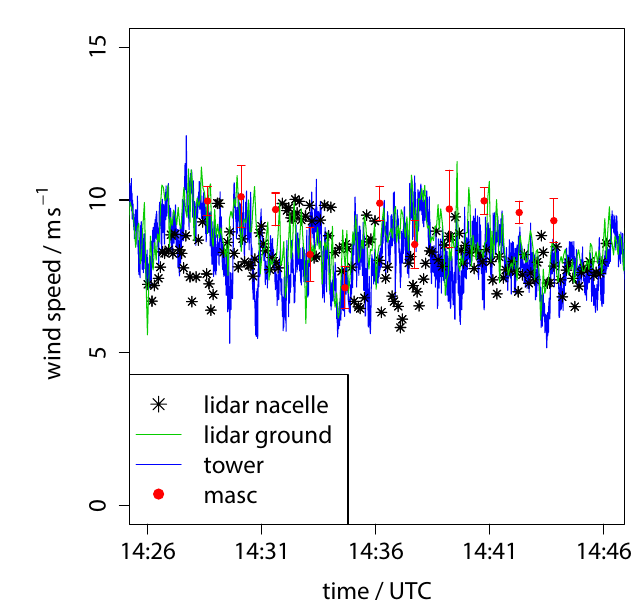
Figure 6. Comparison of horizontal wind speed in the main wind direction measured by tower wind sonic, nacelle-based lidar, ground-based lidar and MASC on 22 October 2013. For the nacelle based lidar, a measuring point 80m in front of the nacelle was cho- sen, for the ground based lidar a measurement point at hub height close to the tower was selected.